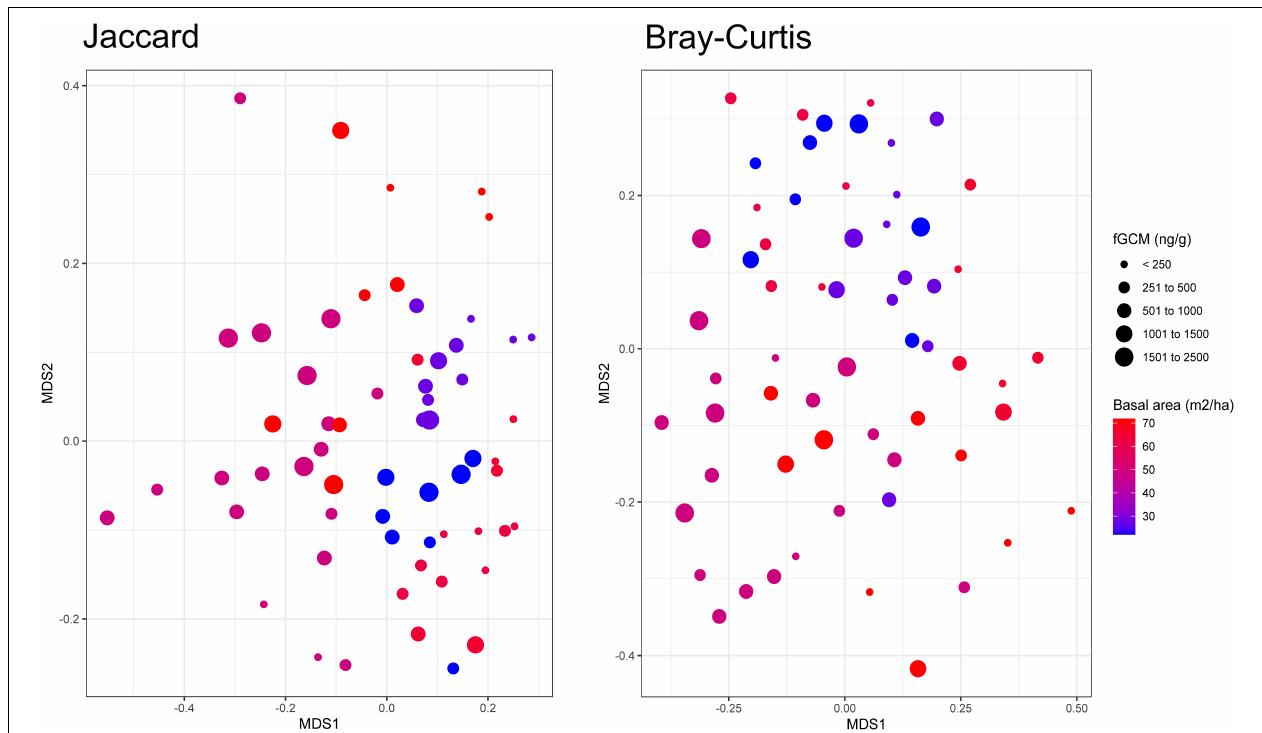
FIGURE 3 | Bacterial community shifts associated with variation in a food availability index and physiological stress of black howler monkeys ( Alouatta pigra ) inhabiting disturbed forest fragments at Escárcega, State of Campeche, Mexico. Bacterial community shifts were influenced by higher stress levels of individuals inhabiting fragments with lower basal area of feeding trees. MDS plots based on Jaccard and Bray–Curtis distance